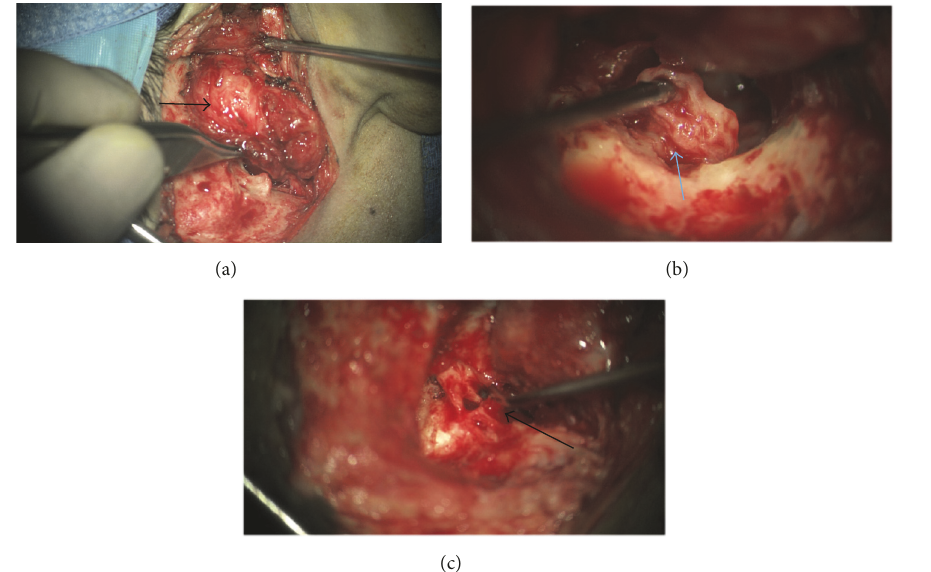
Figure 4: Intraoperative images. (a) Showing lesion filling ear canal and extending out onto the squamous temporal bone (black arrow). (b) Showing disease on the facial nerve (blue arrow). (c) Postremoval of posterior canal wall, showing ossicles and disease on the facial nerve (black